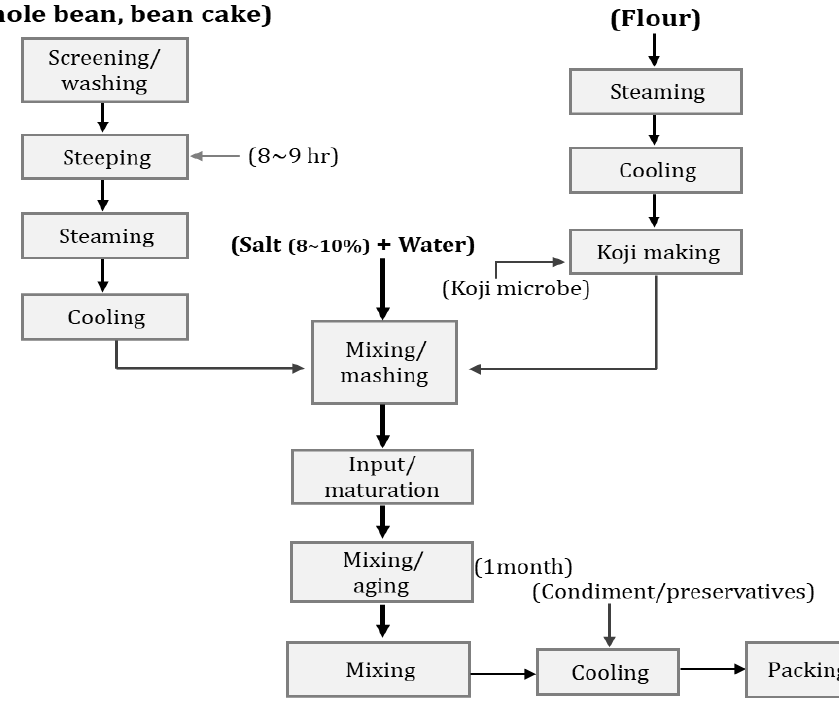
Figure 7. Modified doenjang preparation process